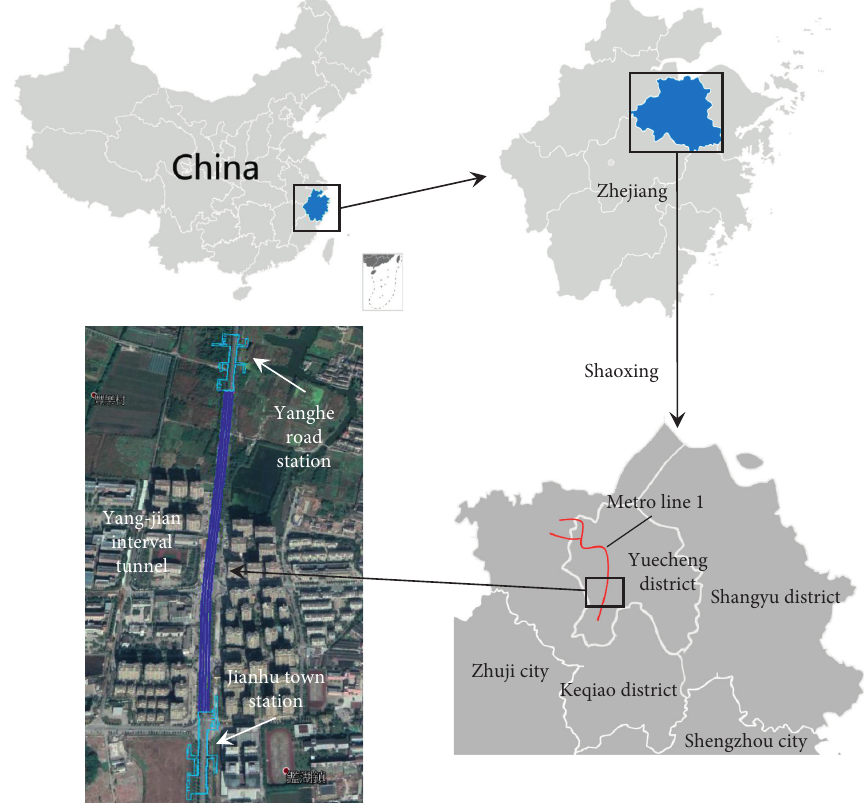
Figure 1: Location of the studied